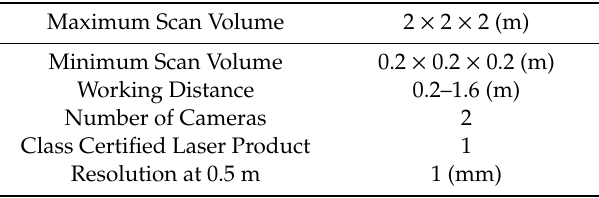
Table 1. Technical specifications of the Sense™ 3D scanner.